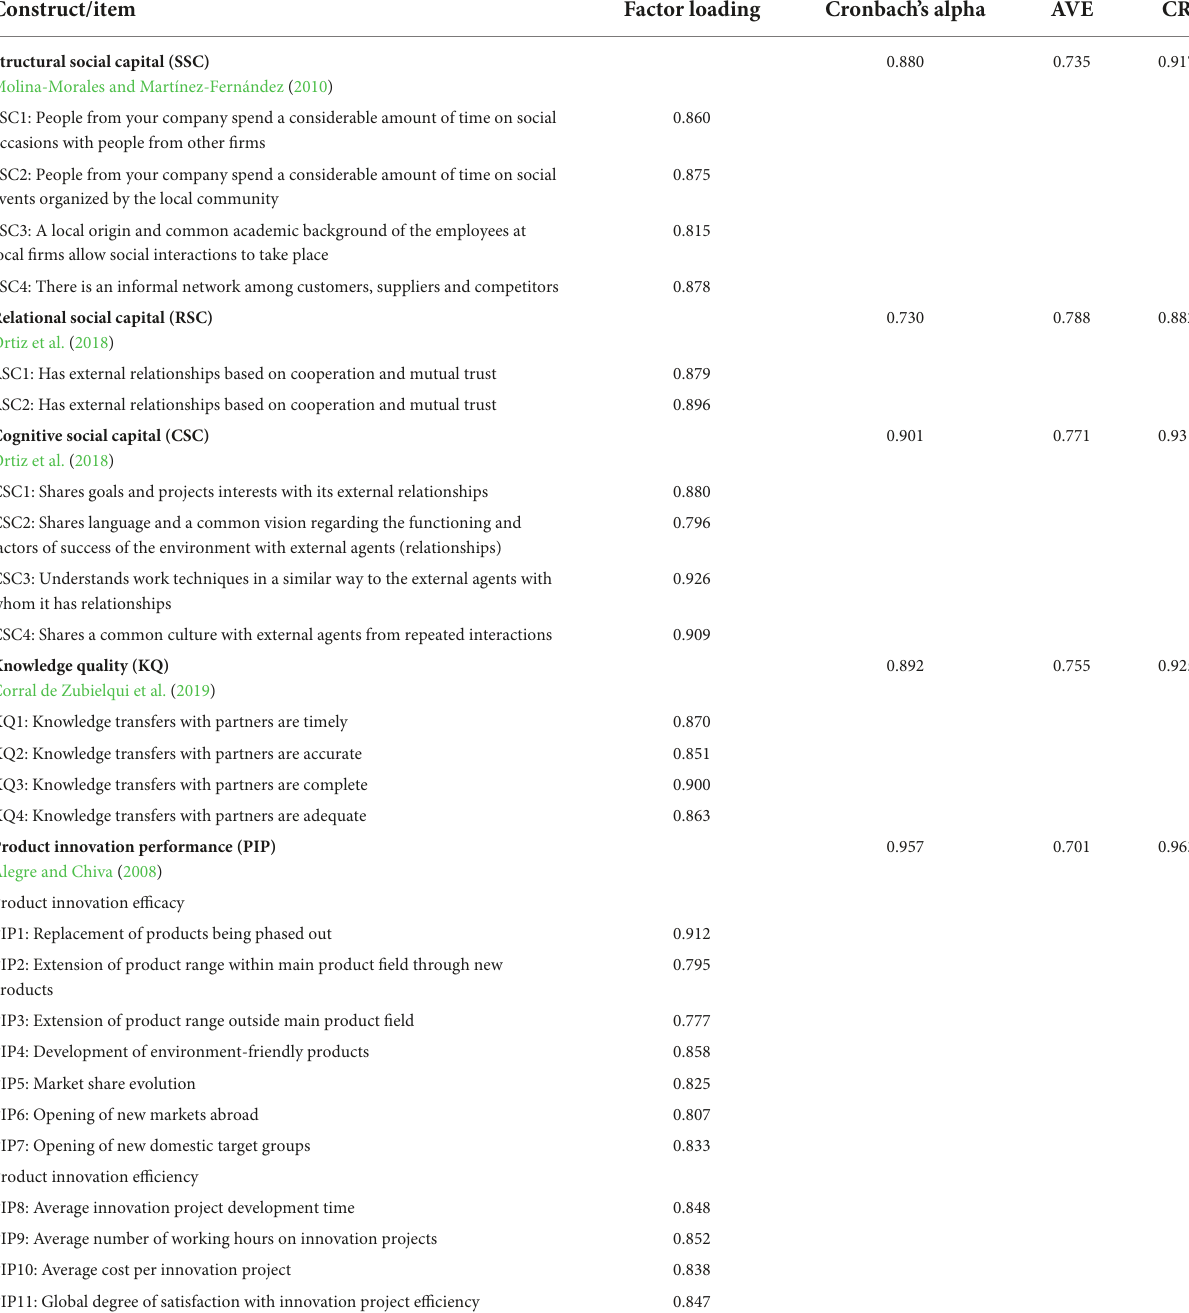
TABLE 2 The indices for construct reliability and convergent